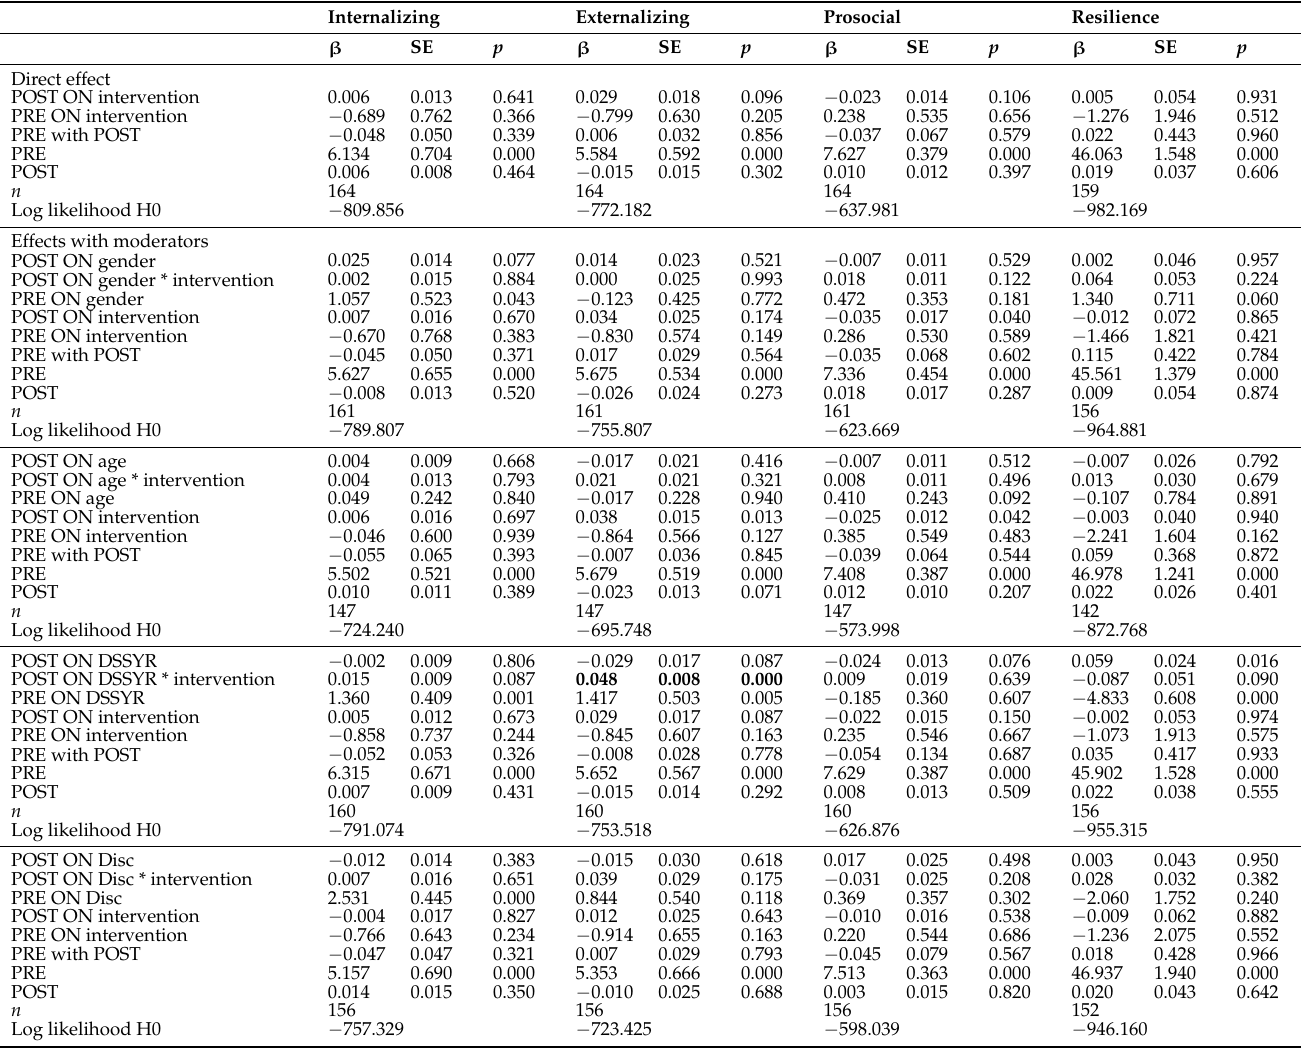
Table 5. Latent growth models for immigrant students regarding INSETT intervention. Internalizing Externalizing Prosocial